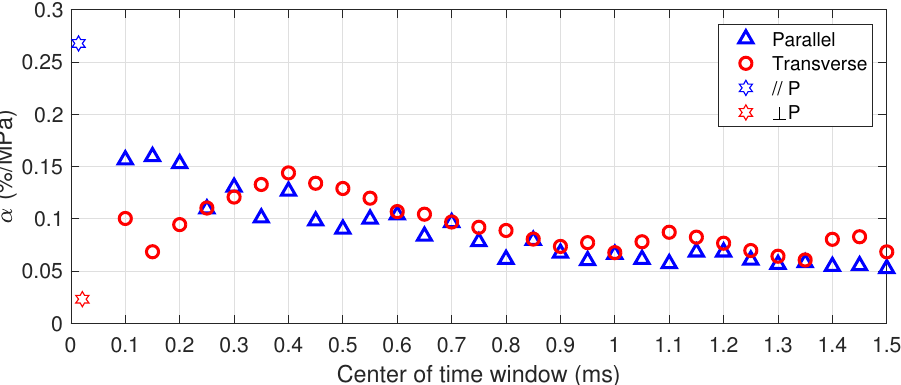
Figure 14. Calculated acoustoelastic coefficients in two directions at different time windows. The window center moves from 0.1 ms to 1.5 ms with a window width of 0.2 ms. The first data point represents the stretching technique analysis on the P wave